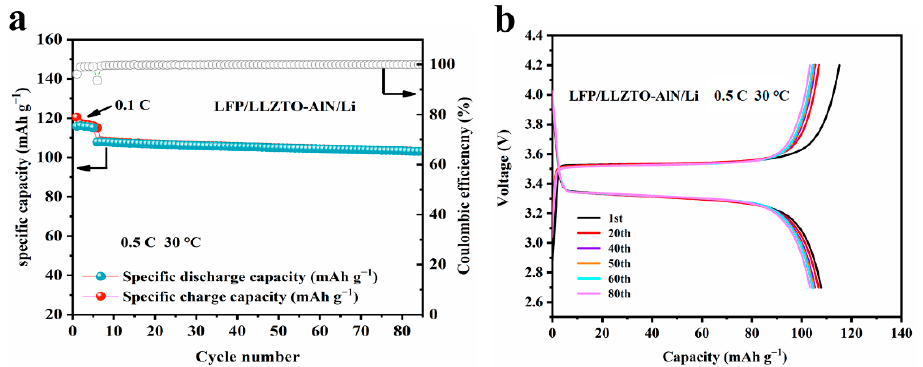
Figure 6. ( a ) Cycle performance of the Li/AlN-LLZTO/LFP cell at 0.5 C current density; ( b ) charge/discharge plateau of the Li/AlN-LLZTO/LFP at 0.5 C.